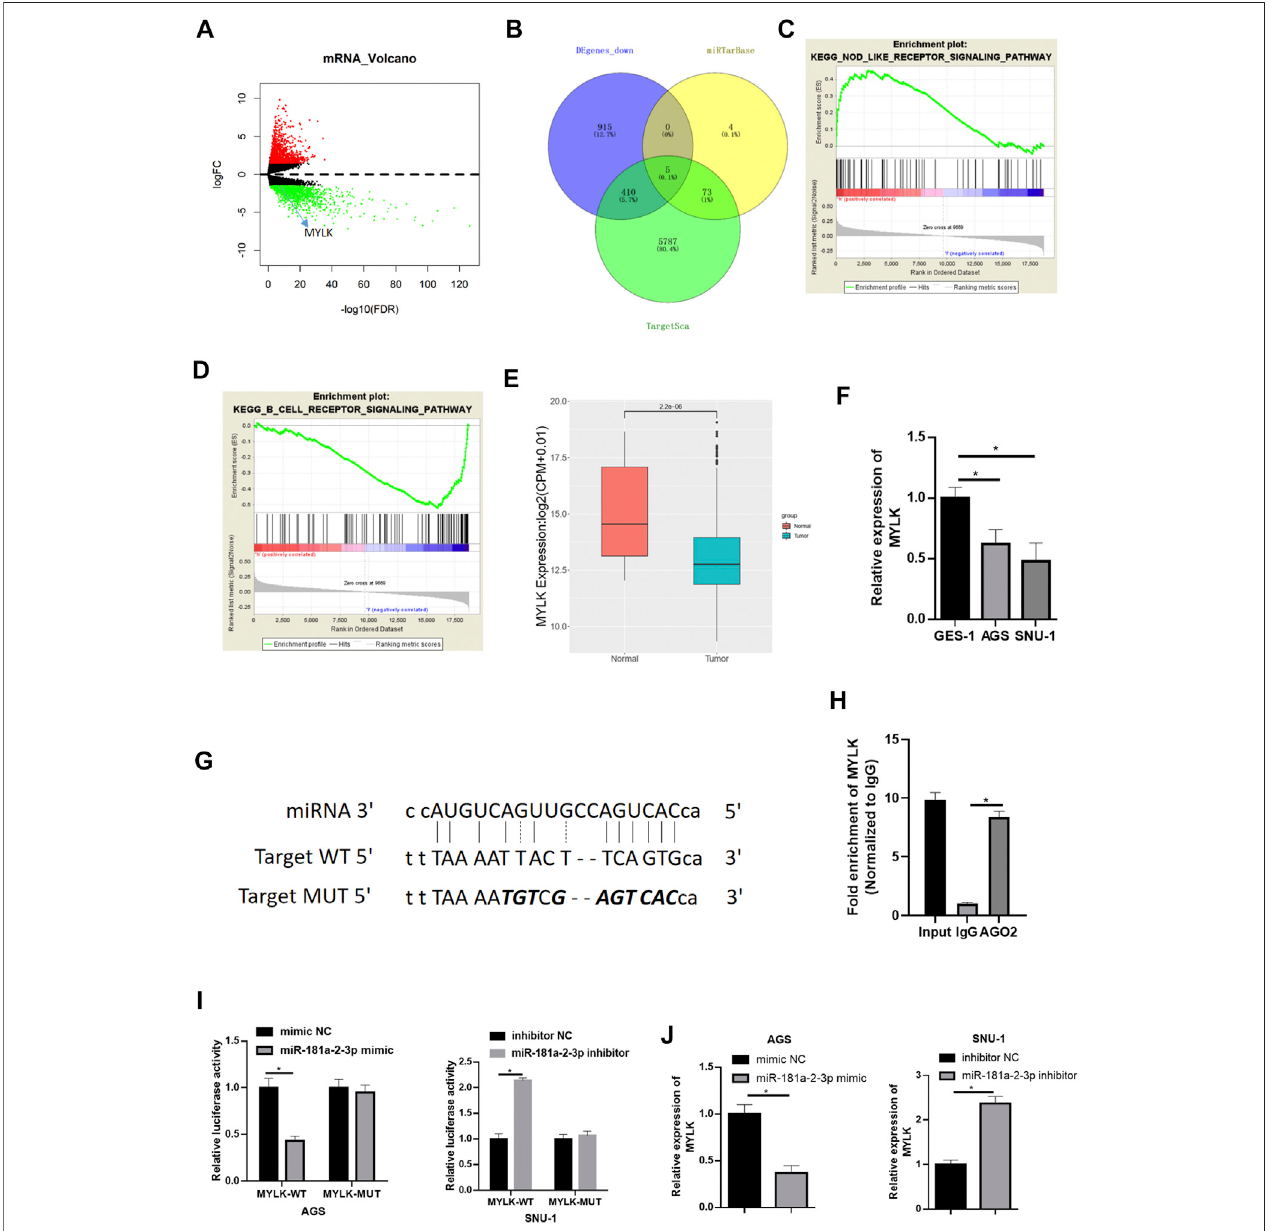
FIGURE 3 | miR-181a-2-3p targets and inhibits MYLK (A) Volcano plot of differential mRNAs in TCGA-STAD dataset (red: up-regulated, green: down-regulated); (B) The intersection of the down-regulated DEmRNAs in TCGA and genes predicted by TargetScan and miRTarBase; The most enriched GSEA pathways of (C) high MKLK expression and (D) low MKLK expression; (E) Differential MYLK in TCGA-STAD (red: normal, blue: tumor); (F) qRT-PCR assayed MYLK in GES-1, AGS, SNU-1; (G) The binding sites of miR-181a-2-3p and MYLK (the italic bold was mutation sites, top: miRNA sequence, middle: wt target DNA sequence of MYLK, bottom mutated target sequence of MYLK); (H) RIP experiments assessed binding relationship of miR-181a-2-3p and MYLK, and the binding relationship was validated by (I) Dual-luciferase reporter gene assay; (J) qRT-PCR was conducted for the determination of MYLK expression; * p <